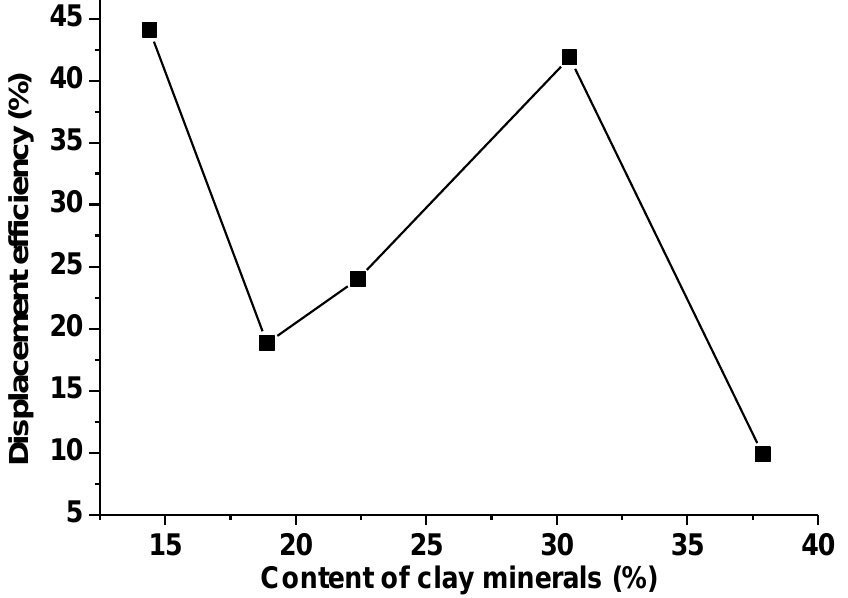
Figure 16. The efficiency of oil displacement under 1 atm versus the content of illite/smectite.